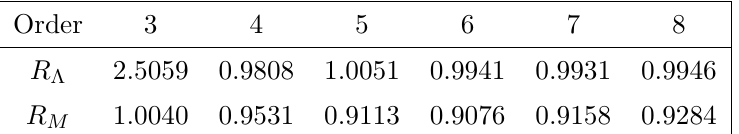
Table 4 . Comparison between the ratio of ratios of the series for (cid:3) and M 2 with their asymptotic values as given by eq.